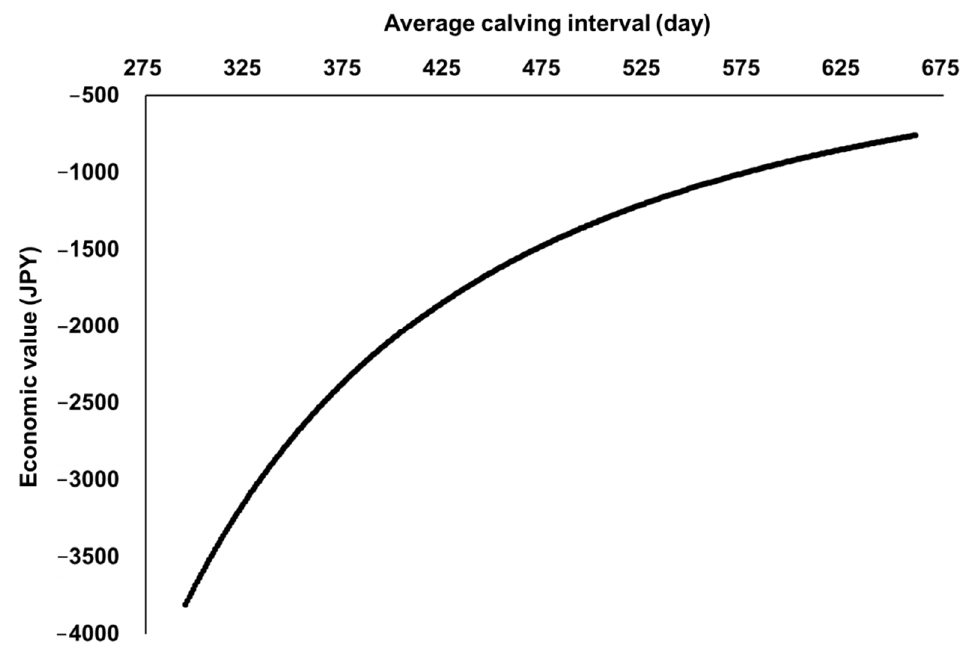
Figure 2. Relationship between calving interval (CI) and economic value for CI. Minimum and Maximum values for CI are shown in Table 1.